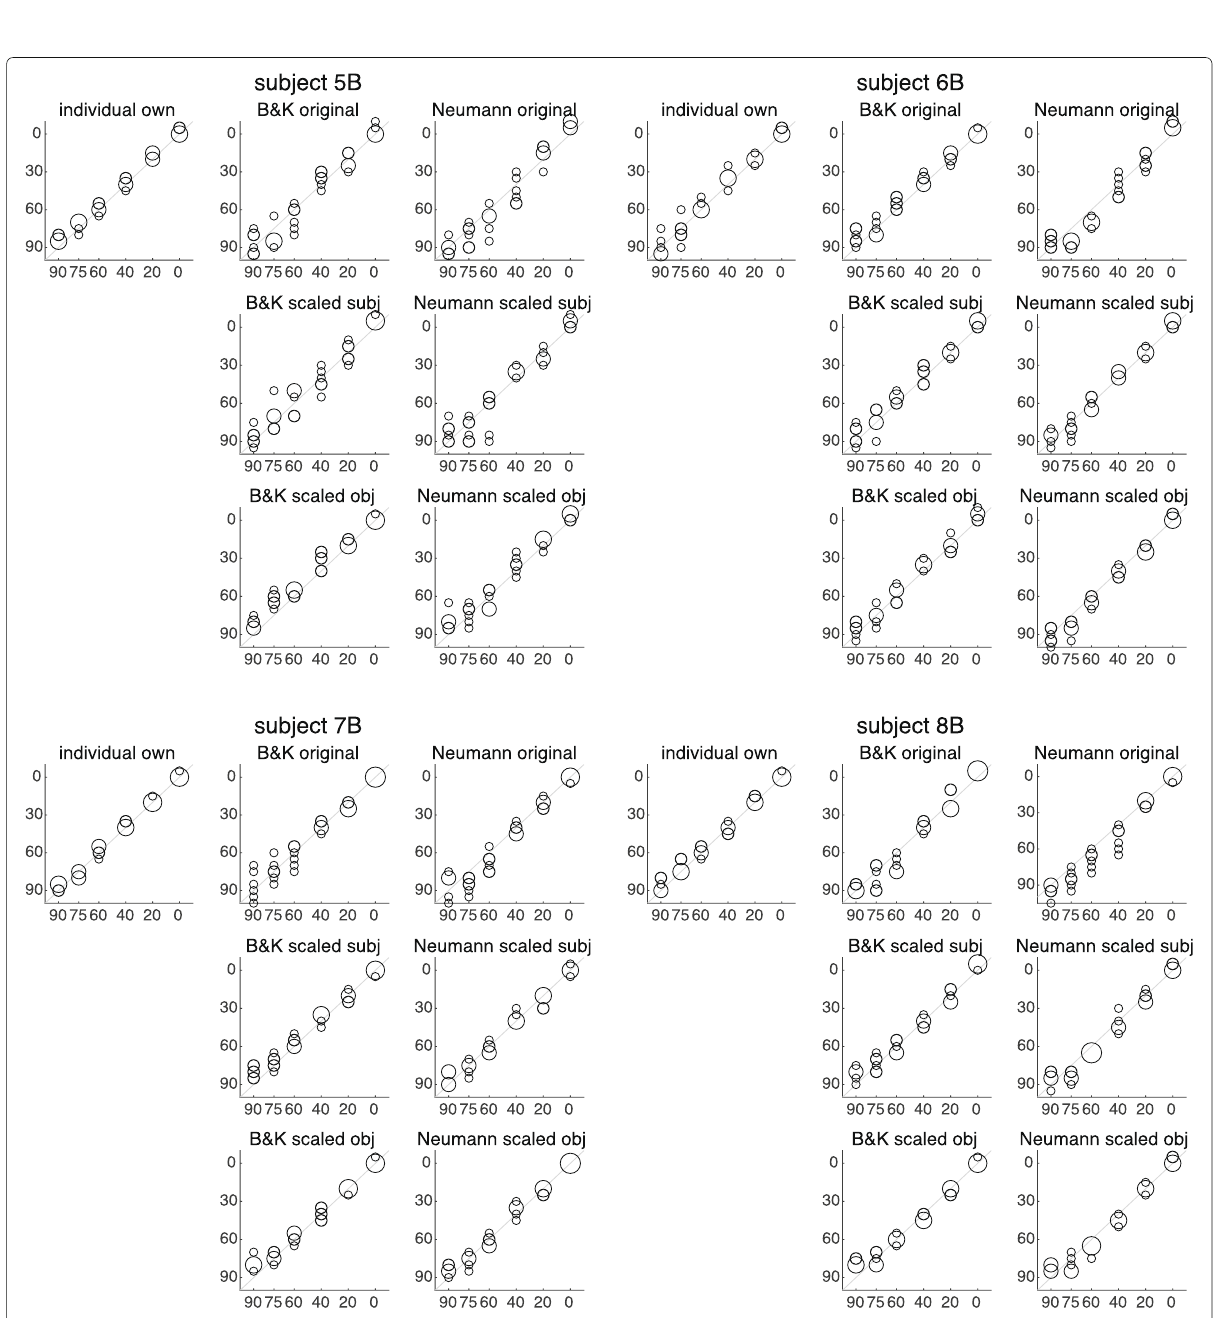
Fig. 11 Results of the validation perceptual test with individually scaled ITD. Subjects 5B to 8B. The abscissa is the simulated azimuth direction and the ordinate is the listener’s perceived direction, both in degrees. The area of each plotted circle is proportional to the number of listener’s responses